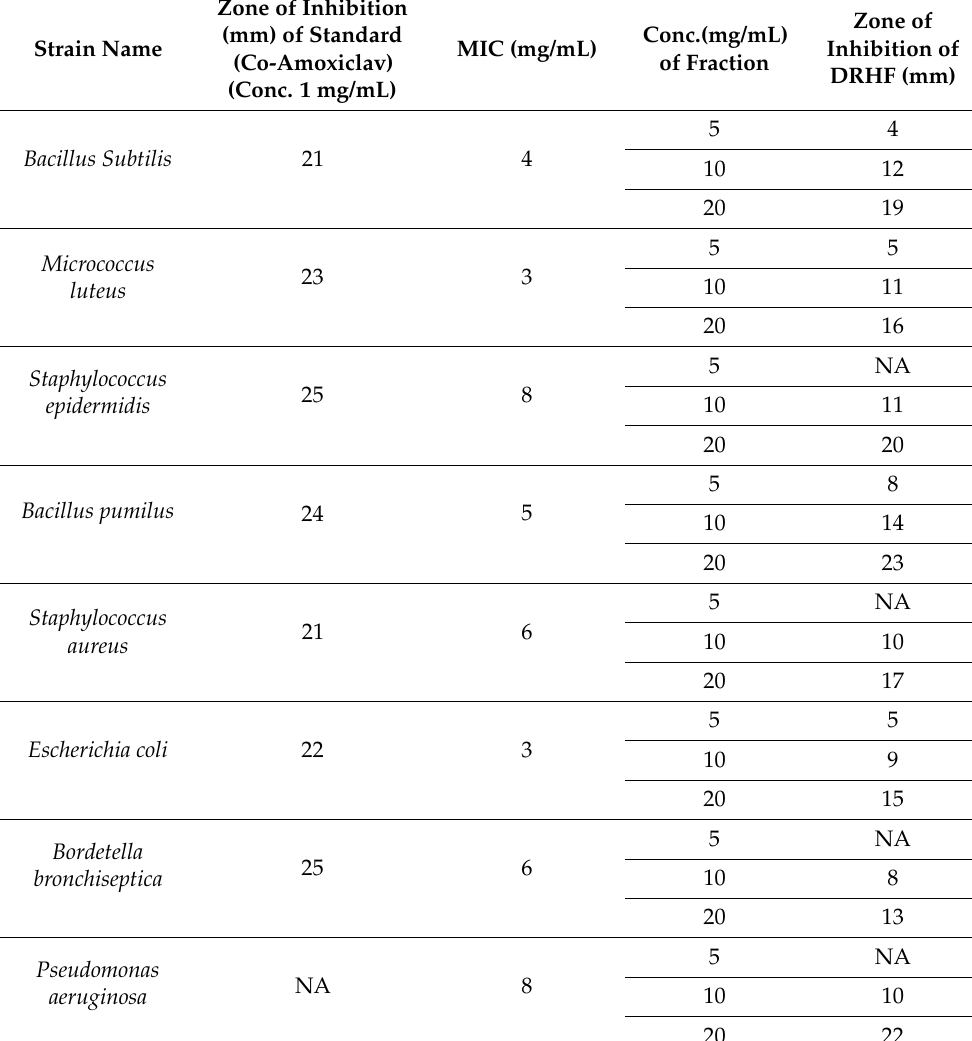
Table 5. Antibacterial activity of n -hexane fraction of Dracaena reflexa